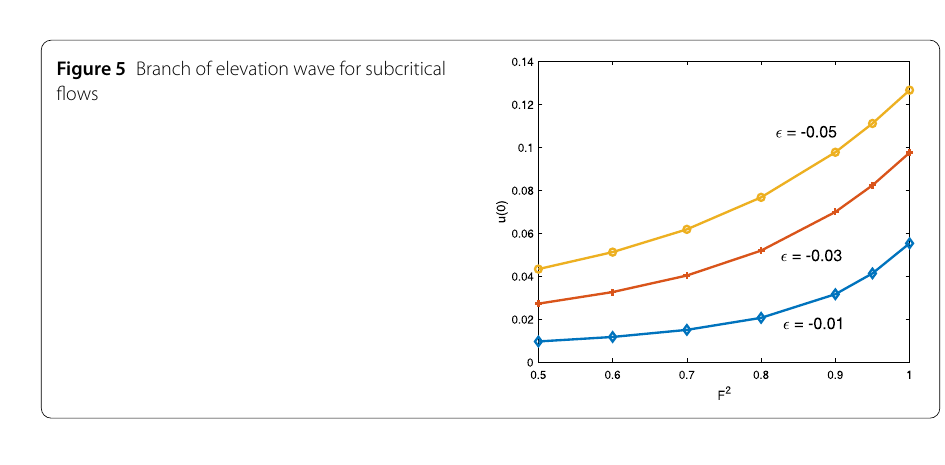
Figure 6 Free surface profile when F 2 = 1.0 and (cid:7) =